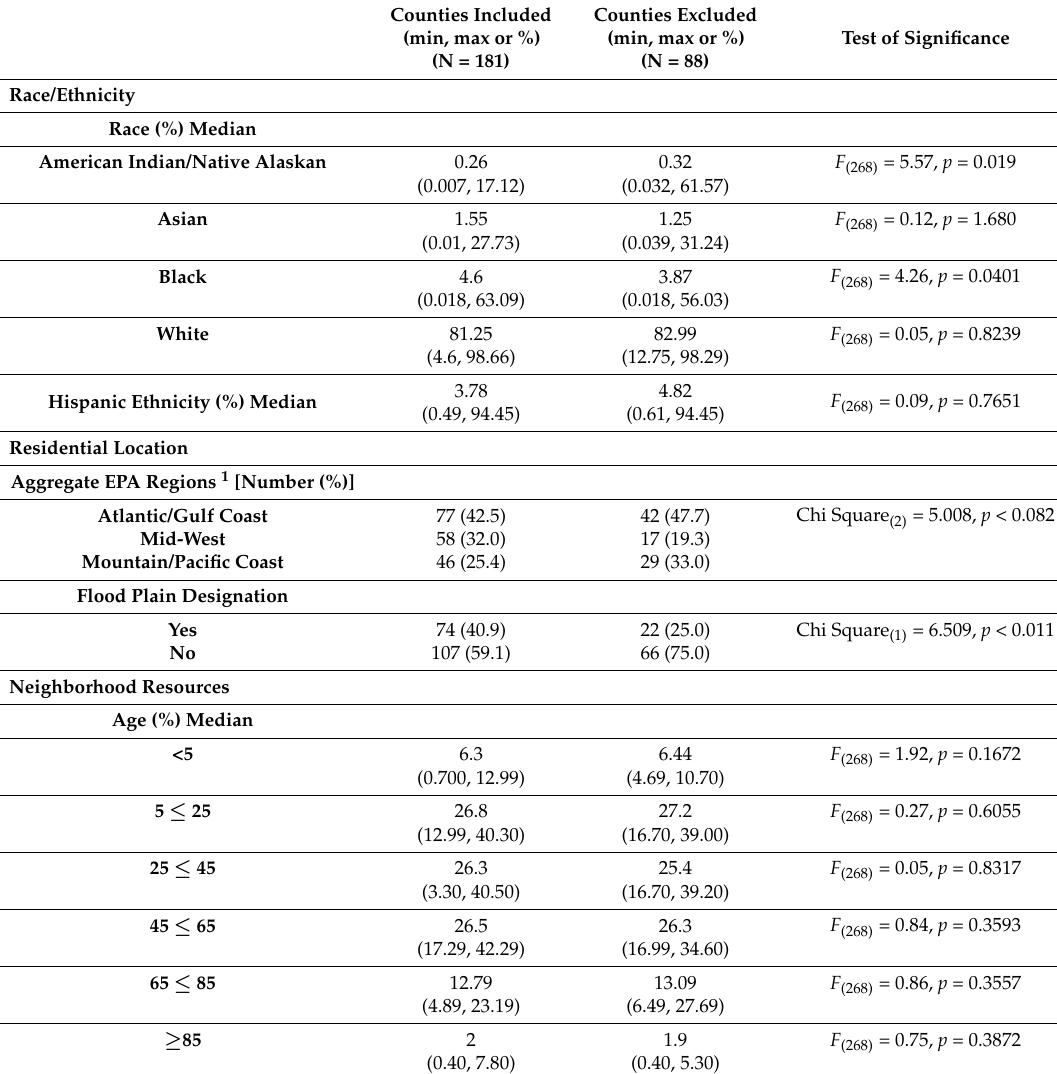
Table 1 tabulates characteristics of counties included in the study and those excluded. Table 1. County race/ethnicity, residential location, neighborhood resources, community environmental stress, and structural factors by study inclusion status.